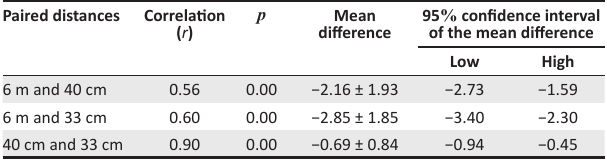
FIGURE 1: Boxplots for the measurements of the amplitude of accommodation using the minus lens method with targets at 6 m, 40 cm and 33 cm. The three numbers outside the box are outliers, which are 1.5 times greater than the interquartile range. TABLE 3: Correlation and mean difference of the amplitude of accommodation in dioptres (D). Paired distances Correlation ( r )